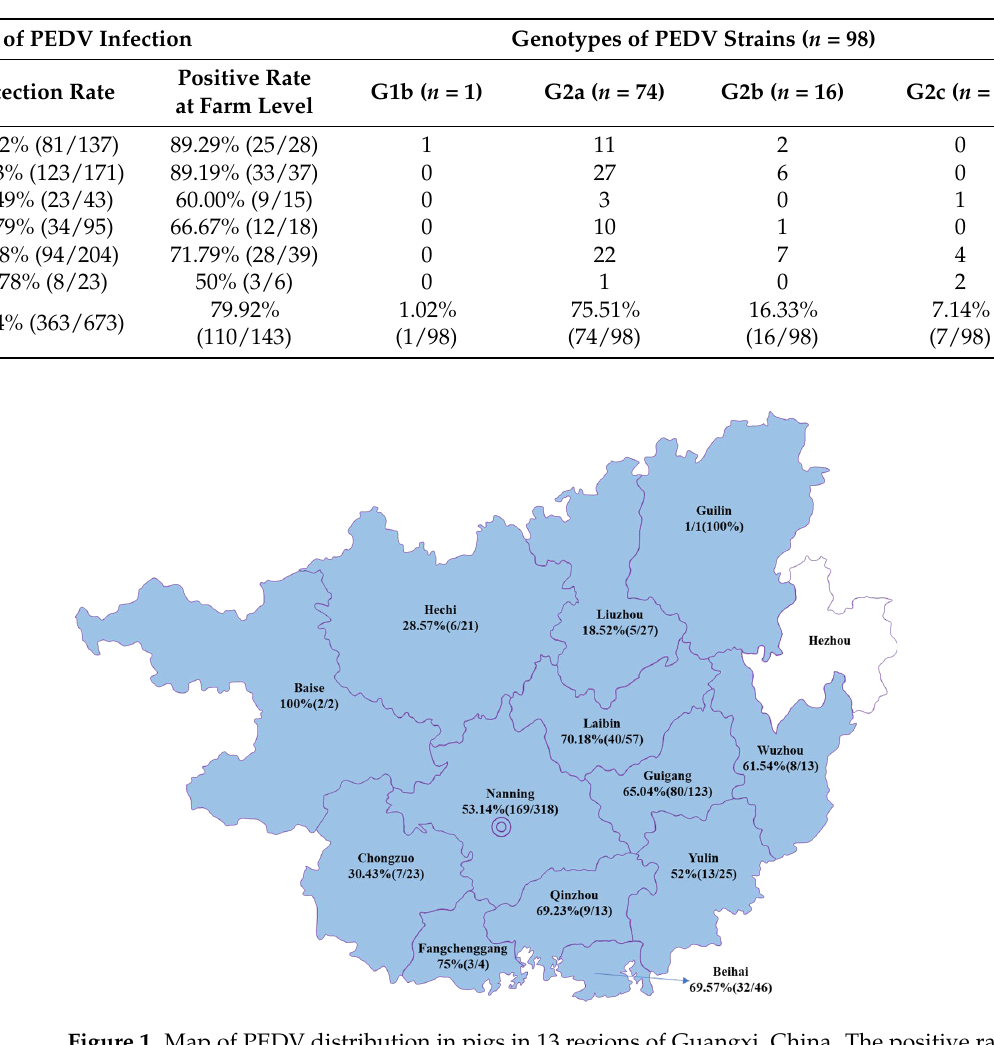
Table 1. The prevalence and genotypes of PEDVs in Guangxi during 2017–2022.